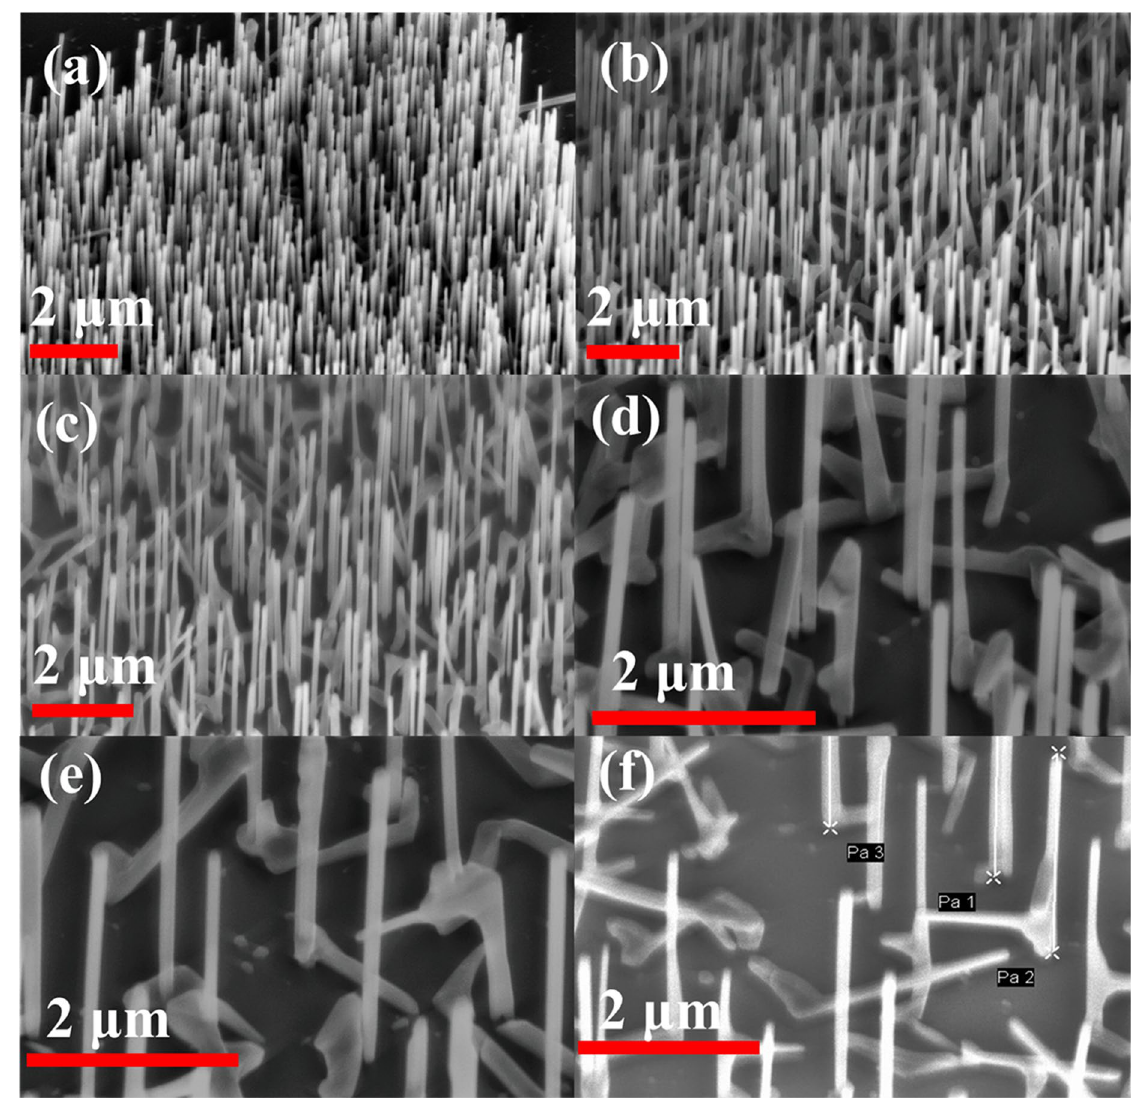
Figure 2. SEM images for GaAsSbN sample B with growth time of 10 min for pitch lengths of ( a – f ) 200, 400, 600, 800, 1000, and 1200